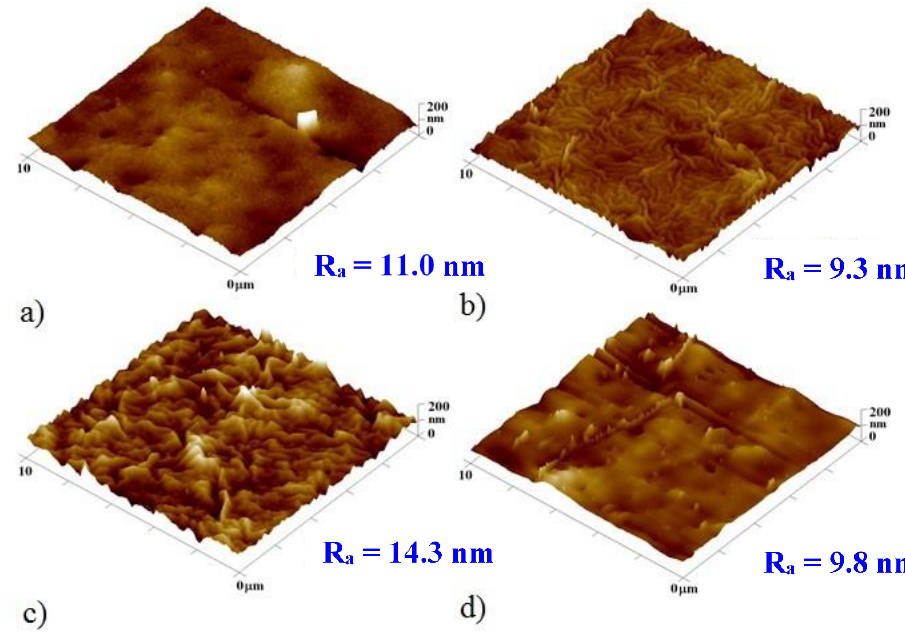
Figure 4. AFM images of the unheated PLLA samples with a sputtered titanium bottom layer and gold top layer. ( a ) Ti and Au layers of 2 and 48 nm, respectively; ( b ) Ti and Au layers of 5 and 45 nm, respectively; ( c ) Ti and Au layers of 10 and 40 nm, respectively; ( d ) Ti and Au layers of 25 and 25 nm, respectively. R a is the mean surface roughness in nanometers.